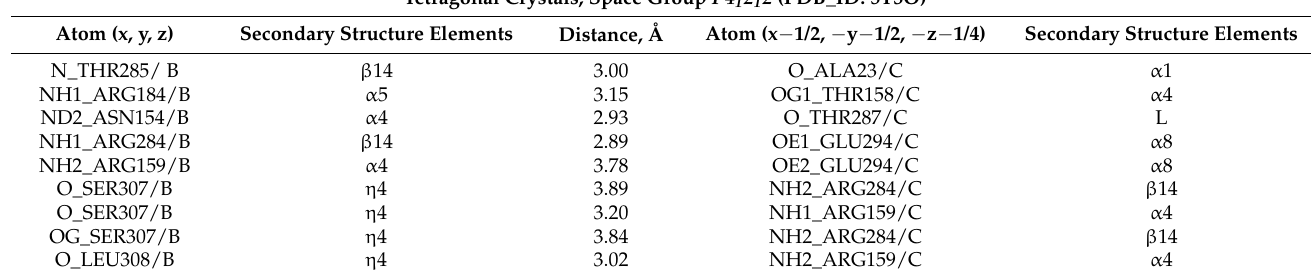
Table 2. Polar contacts between molecules in crystal structures of tetragonal (sp. gr. P4 1 2 1 2 ) and rhombohedral (space group R3 2 -h )